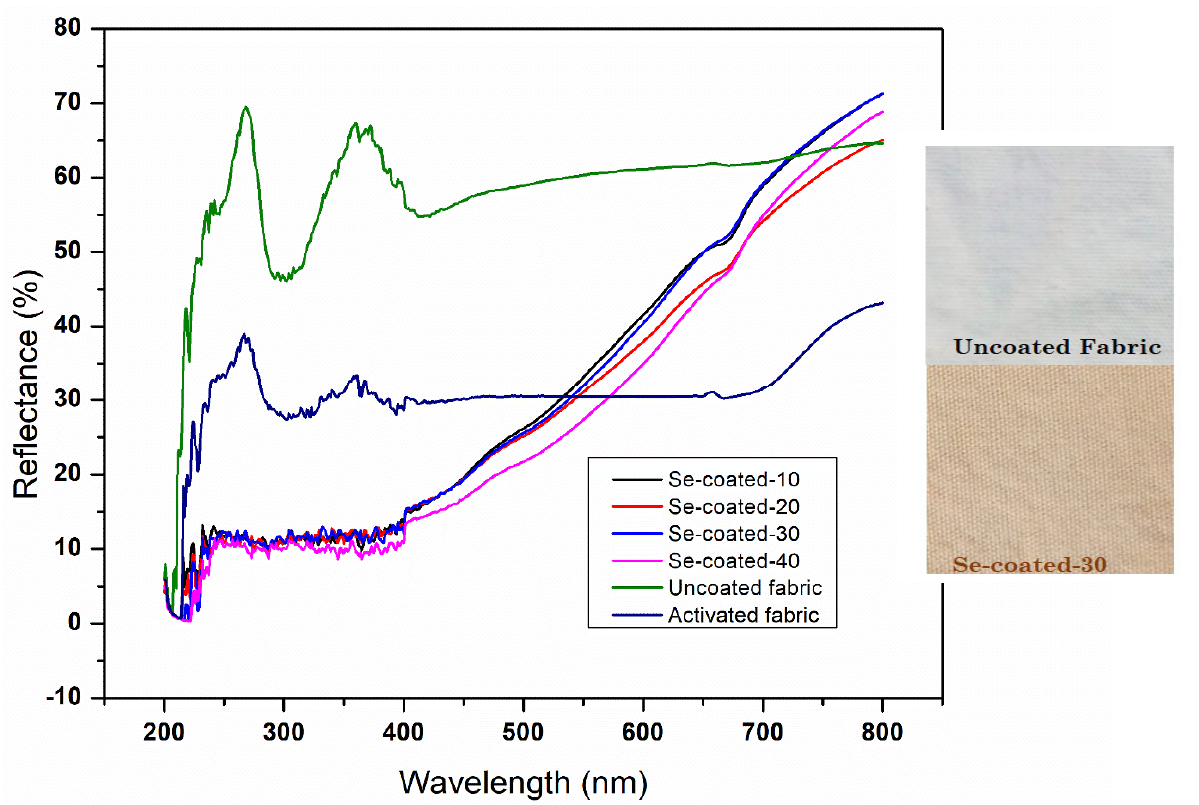
Figure 2. UV − Vis reflectance spectra of cotton samples. The images show the visual color change in cotton fabric. The different concentrations of sodium selenite (10–40 mM) were applied on the activated fabric followed by reduction with guava leaf extract and the reflectance spectra were compared in the wavelength range of 200–800 nm. uncoated and activated fabric served as control.